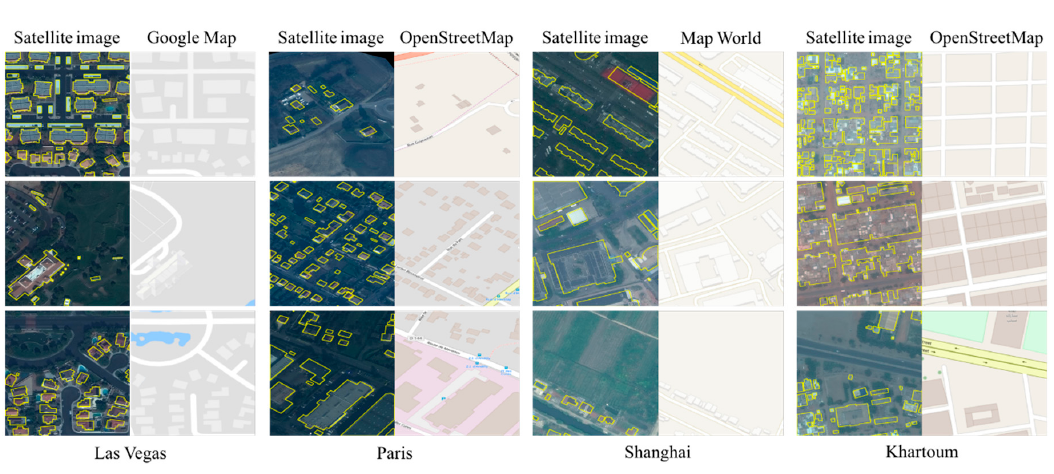
Figure 1. Examples of WorldView-3 satellite images, annotated building footprints (denoted by yellow polygons), and multi-source geographic information system (GIS) map images of four cities.